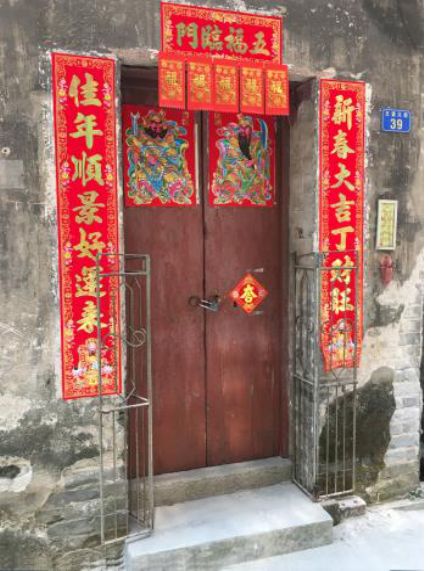
Figure 10. External folding steel gate (source: the authors).